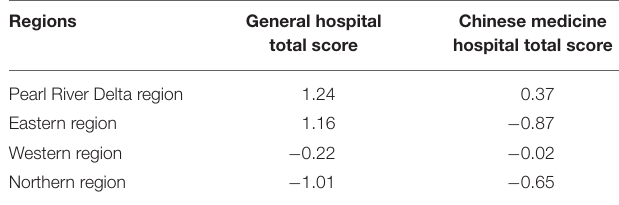
TABLE 6 | Reform performance of various regions in Guangdong